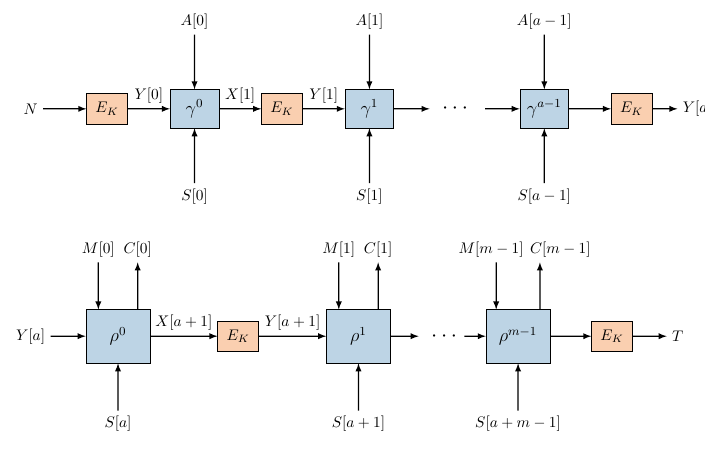
Figure 1: General Structure of Feedback-based Authenticated Encryption